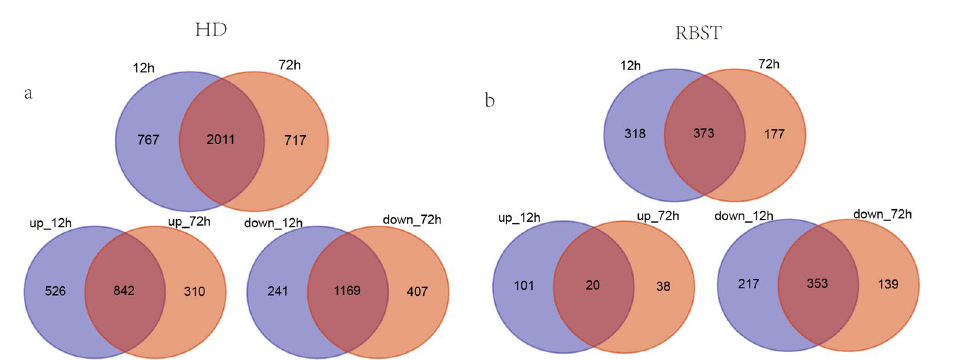
Figure 2. Summary for the differentially expressed genes. Venn diagram showing the number of specific and common differentially expressed genes. ( a ) Differentially expressed genes of HD between 12 h and 72 h. ( b ) Differentially expressed genes of RBST between 12 h and 72